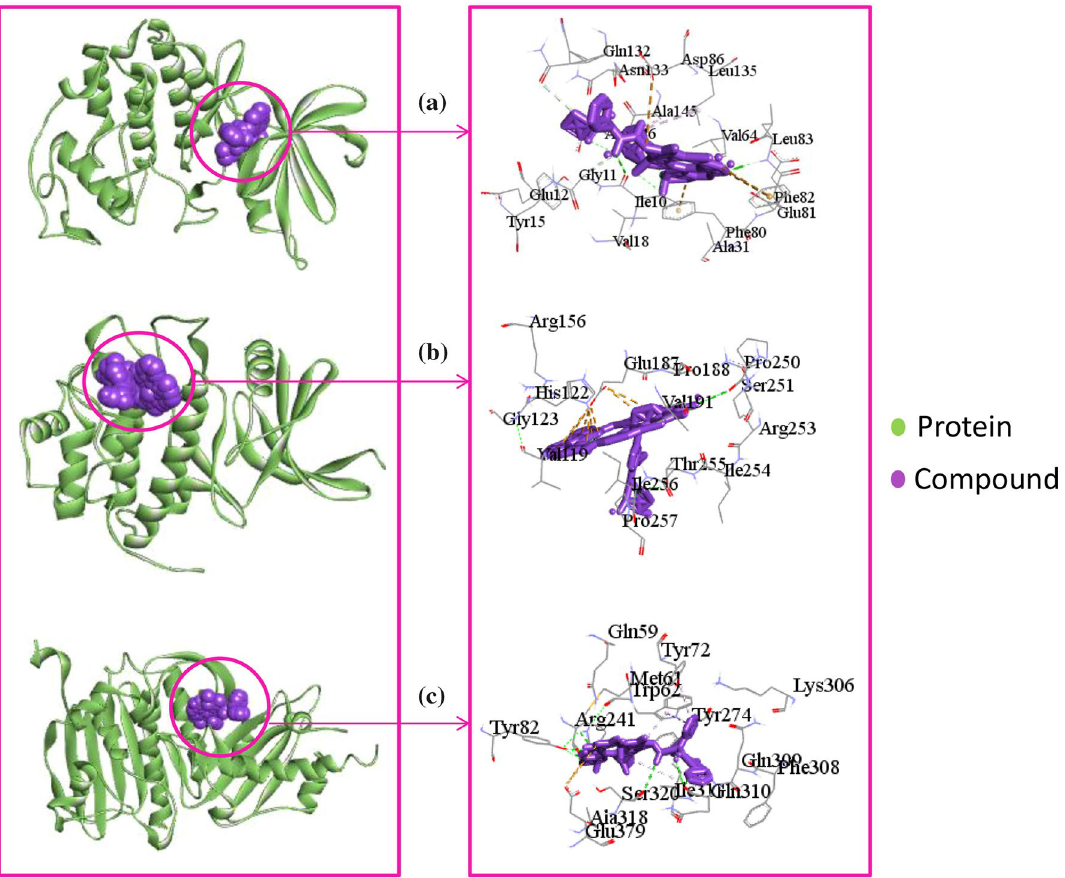
Fig. 6 The top-ranked three complexes obtained from molecular docking study and its 2D chemical interactions. The figure is generated by using discovery studio visualizers. Complexes: a indicated CDK1_Docetaxel, b indicated CHEK1_Temsirolimus, and c indicated TOP2A_Pacli-